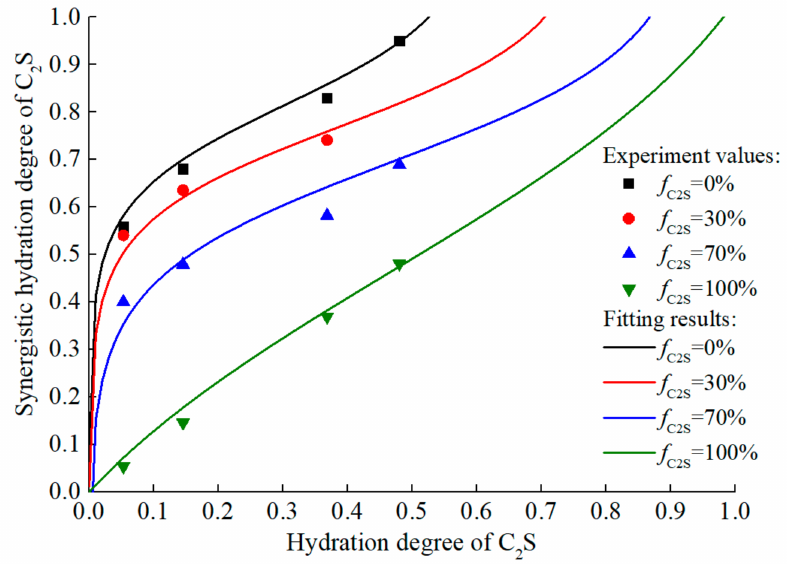
Figure 12. Synergistic hydration effect of mixed systems with different f